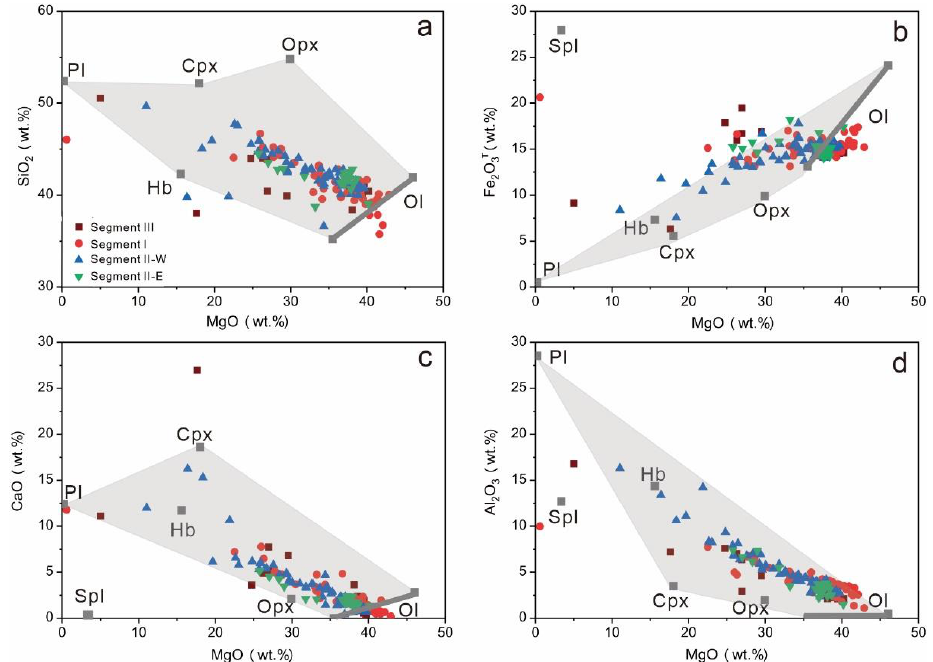
Figure 4. Harker diagram of the whole-rock major elements of mafic–ultramafic intrusions samples from the Jinchuan deposit. ( a ) MgO vs. SiO 2 , ( b) MgO vs. Fe 2 O 3T , ( c) MgO vs. CaO, and ( d ) MgO vs. Al 2 O 3 . Data from this study and [23,29,36,38,44]. The chemical compositions of olivine (Ol), clinopyroxene (Cpx), orthopyroxene (Opx), spinel (Spl), plagioclase (Pl), and hornblende (Hb) are from